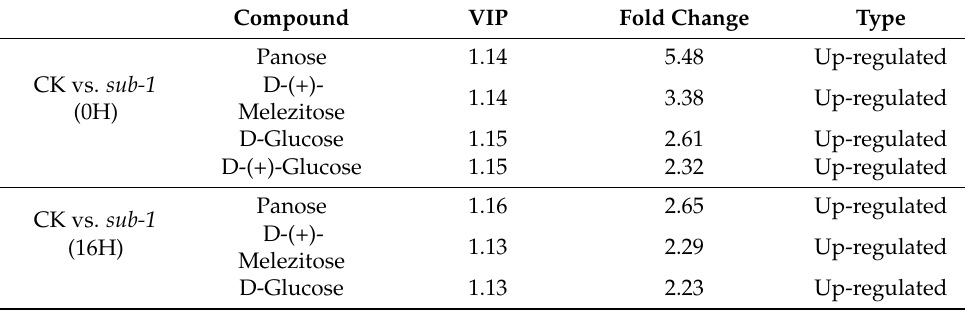
Table 4. Differentially accumulated carbohydrate